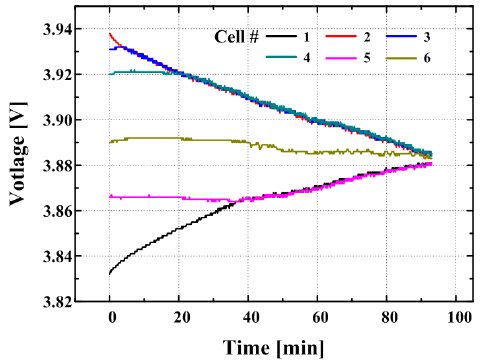
Figure 9. Voltage versus balancing time for the proposed charge equalization; six cells were connected in a static condition.